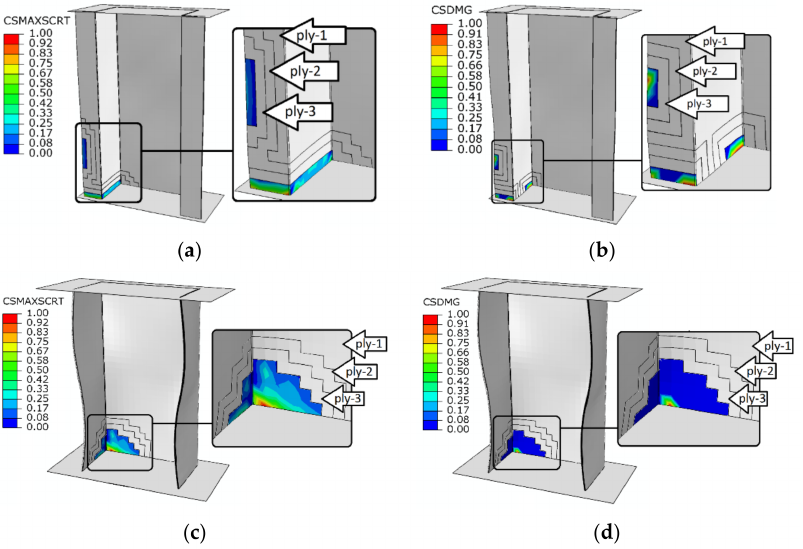
Figure 8. Damage initiation and evolution (CZM) caused by delamination: ( a ) damage initiation of top-hat column—CSMAXSCRT; ( b ) damage evolution of top-hat column—CSDMG; ( c ) damage initiation of channel column—CSMAXSCRT; ( d ) damage evolution of channel